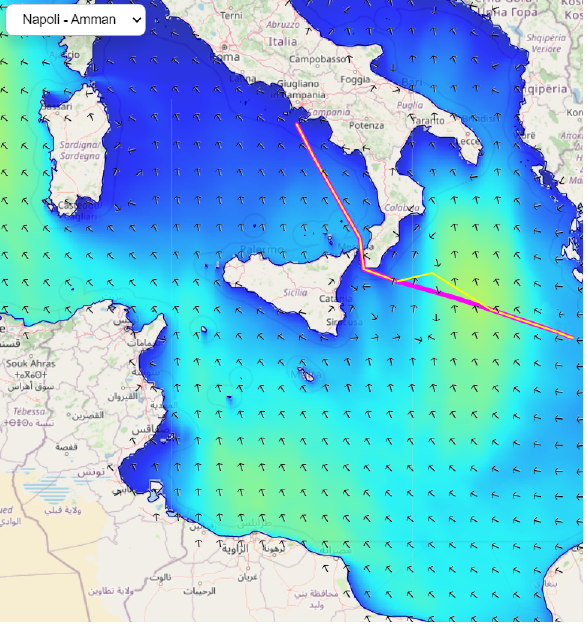
Figure 5. Alternate route recommendation on route